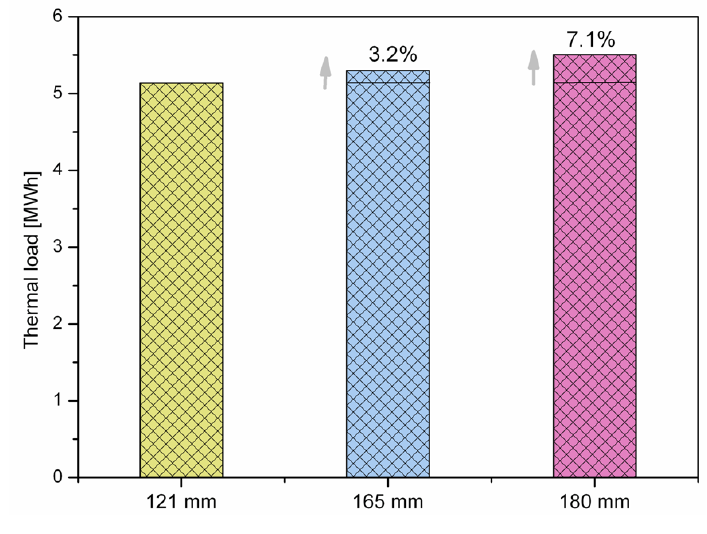
Figure 14. Comparison of seasonal thermal efficiency of BHE with different drillhole